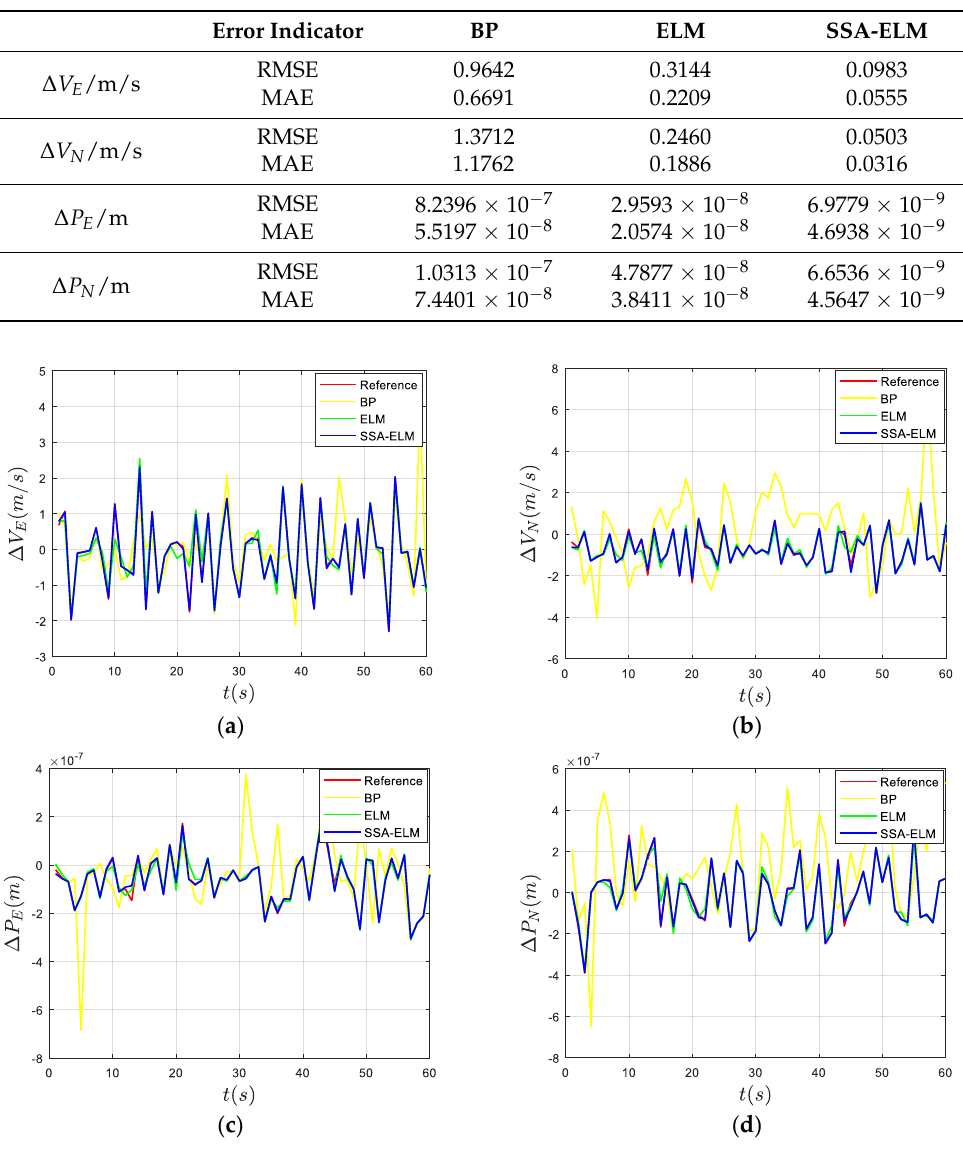
Figure 12. Prediction of the velocity and position differences of different methods during the fourth interruption: ( a ) east velocity difference prediction, ( b ) north velocity difference prediction, ( c ) east position difference prediction, and ( d ) north position difference prediction. Table 9. RMSE and MAE of the velocity and position differences of different methods during the fourth interruption.